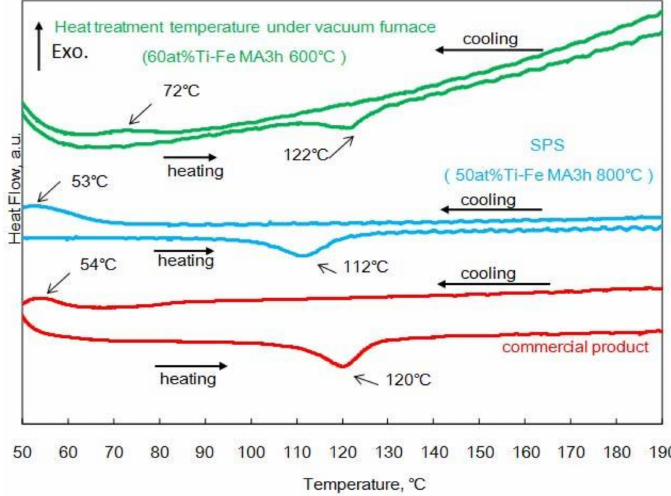
Figure 10. DSC measurement curves of various Ti-Fe